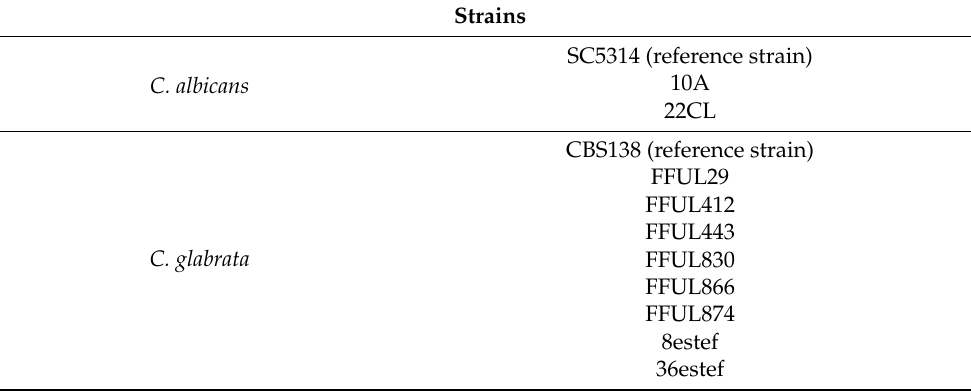
Strains SC5314 (reference